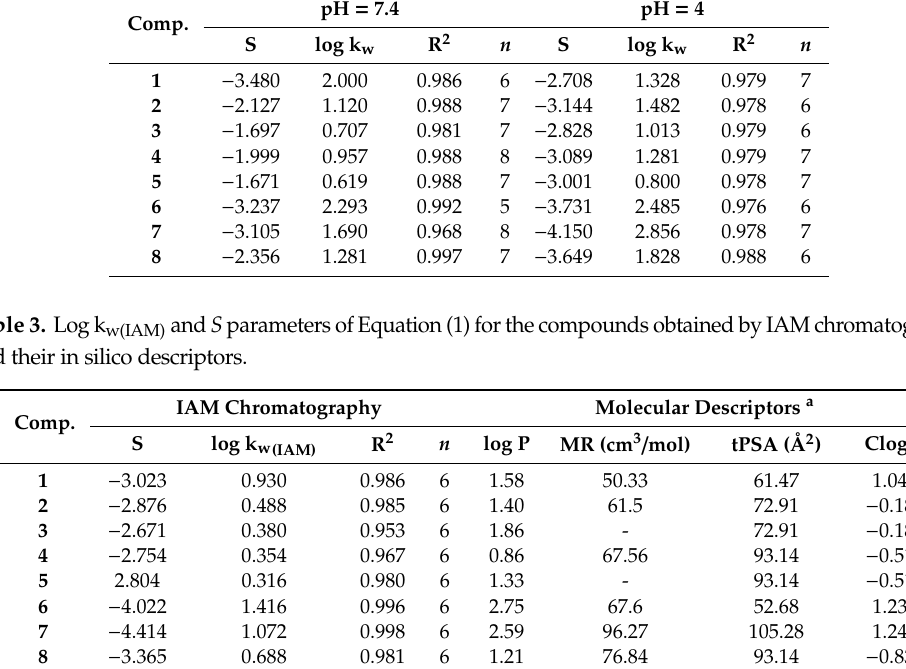
Table 2. Lipophilicity parameters of compounds: log k w and S values (Equation (1)) obtained by RP-18 HPLC chromatography. Comp.